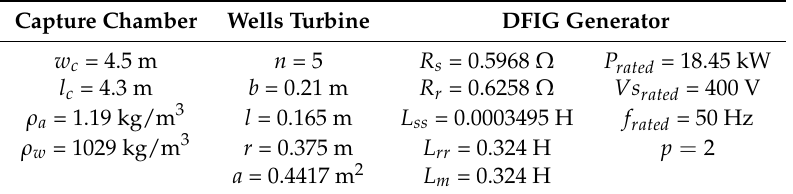
Table 1. Plant parameters from the NEREIDA wave power plant at Mutriku. Capture Chamber Wells